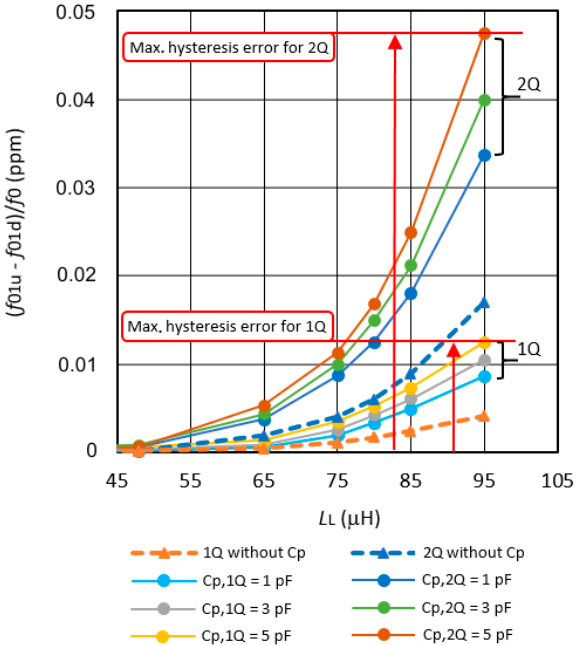
Figure 5. The relative frequency differences f 01u − f 01d / f 0 depending on the connection of the single- or dual-quartz crystal units in the oscillator without the capacitance C p and for different capacitance values C p = 1–5 pF.